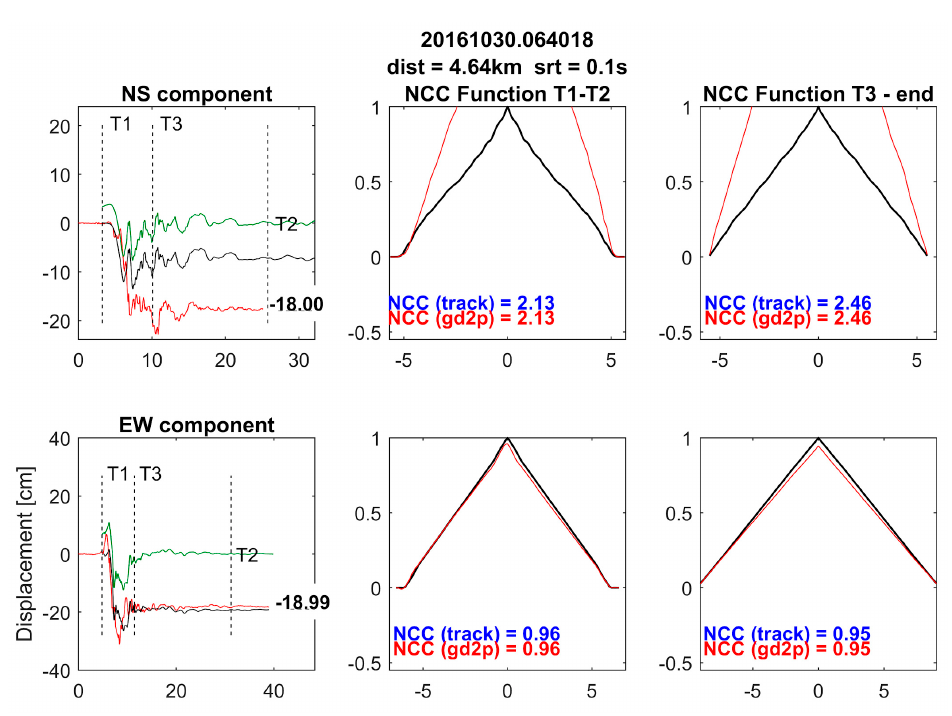
Figure A1. Comparison between displacement time series (two horizontal and vertical component) obtained by the eBASCO method (black line) and from the ESM database (green line) recorded at the IV.T1213 station during the Mw6.5 Norcia earthquake and HRGPS time series from the co-located MSAN station. The coseismic displacement measured by HRGPS is also reported in the 1st column of each plot together with the correction points (T 1 , T 2 and T 3 ). Normalized autocorrelation function (ACC) (black line) and normalized cross-correlation (NCC) function between HRGPS and eBASCO displacement (red line) are shown in the 2nd and 3th columns. ACC and NCC were calculated between T 1 and T 2 (2nd column) and between T 3 and the end of signal (3th column); dist: interdistance between strong-motion and GPS station; srt: sampling rate of the HRGPS records; gd2p and track: different processing schemes of the HRGPS data (http://gipsy.jpl.nasa.gov (accessed on 29 December 2020) , [27]; http://wwwgpsg.mit.edu/~simon/gtgk/ (accessed on 29 December 2020) , [28]).